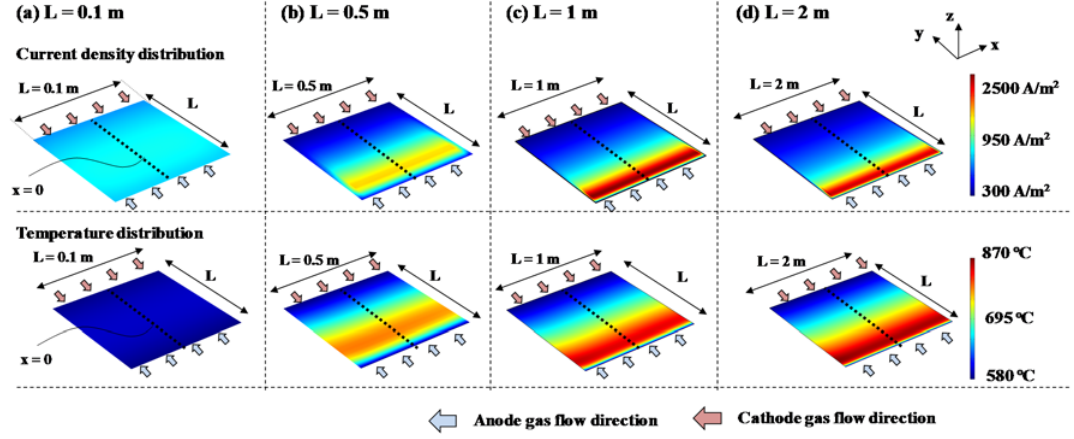
Figure 7. Current density and temperature distribution relative to the length for the counter ‐ flow type.